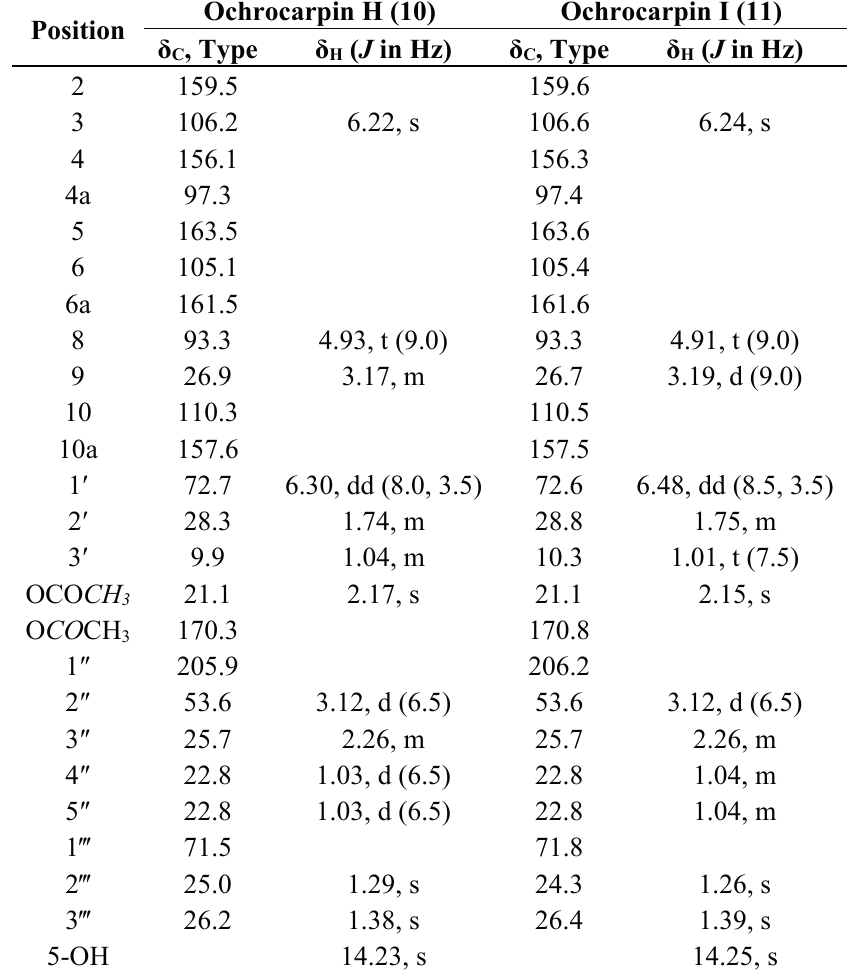
Table 3. 1 H- (500 MHz, CDCl 3 ) and 13 C-NMR (125 MHz, CDCl 3 ) data for ochrocarpin H ( 10 ) and ochrocarpin I ( 11